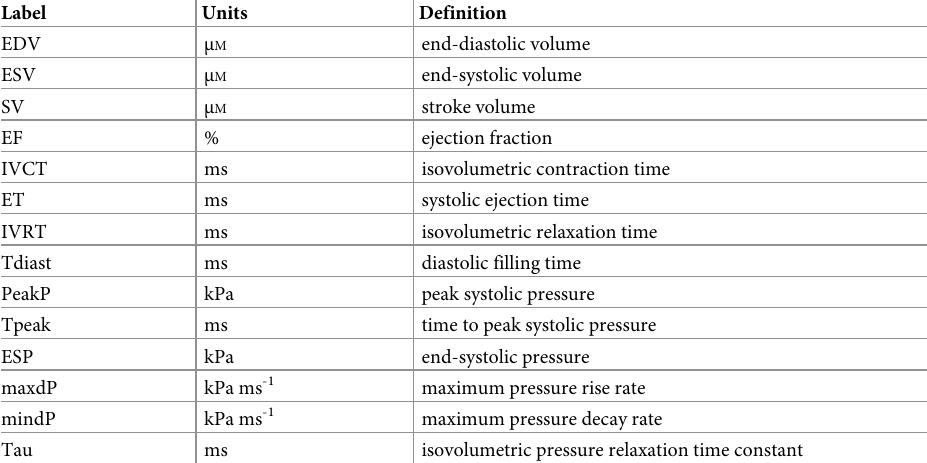
Table 2. Model output LV features.